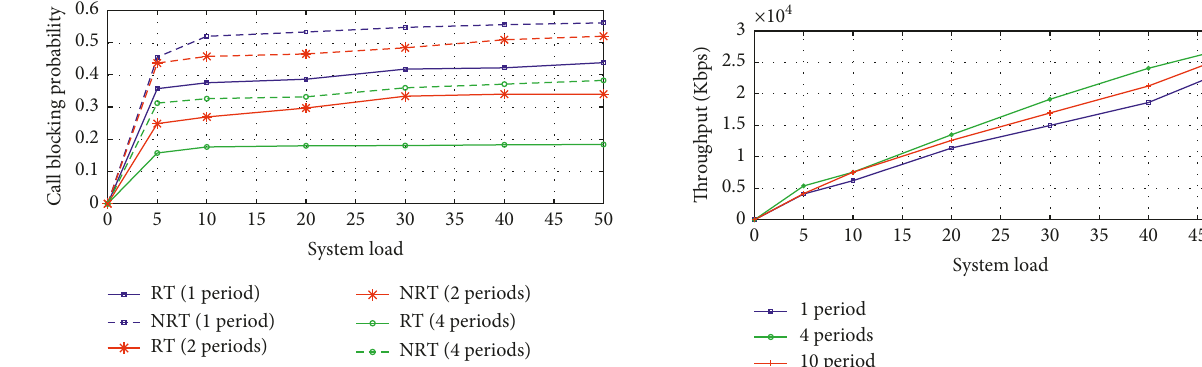
Figure 8: Throughput (widespread rain event).